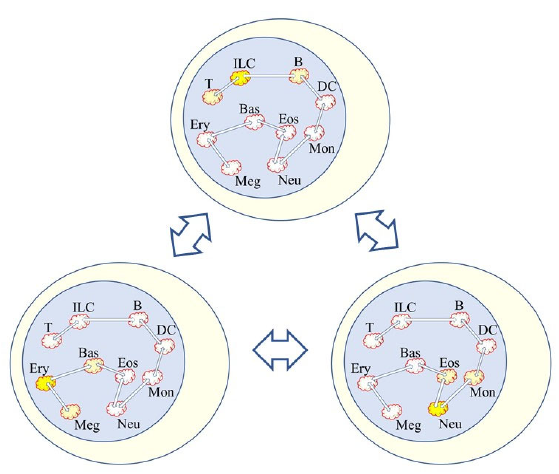
Figure 2. Low level bursting of gene expression within HSCs. HSCs are able to ‘choose’ directly from all of the options. The bursting of gene expression at a various site for a particular fate is shown by the bright yellow highlighted clouds. The noise is not exclusive to just a pathway of development because developmental trajectories are broad and there are near-neighbor relationships between the cell lineages. The close relationships shown between the pathways of development are as for continuum and diffusion map models of hematopoiesis. Trajectories are broad and binary flips to an adjacent landscape are shown by the clouds with a reduced yellow highlighting. The depiction is in keeping with the mathematical embedding together of bi-stable